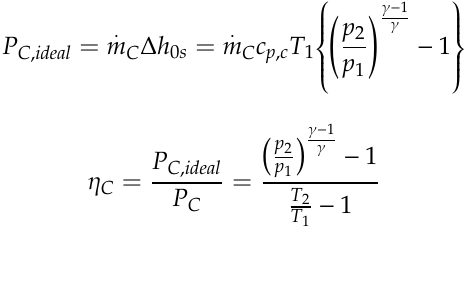
Figure 11. Tip-in test for the EAT system